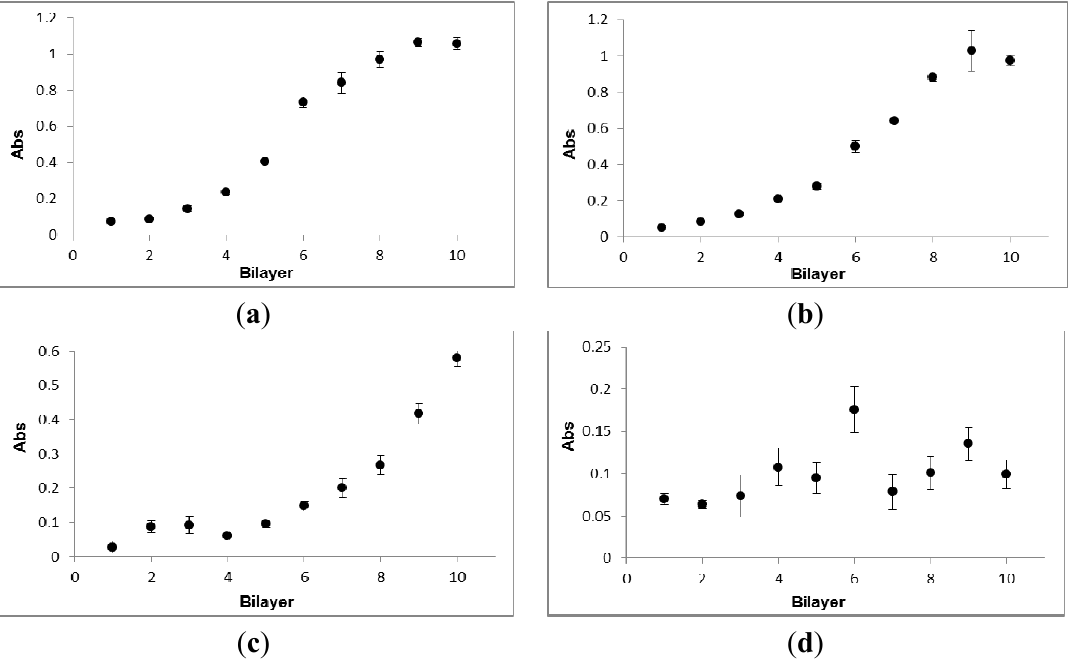
Figure 4. Plot of the average absorbance between 190–220 nm monitoring the growth of chitosan (CHI)/hyaluronan (HA) bilayers deposited by adaptations of the original protocol. Three trials were done for each bilayer to account for minor compositional variances. Water rinse was for 1 min. Error bars represent standard deviation. The following variations of the original protocol were performed: ( a ) Increased rinse times, volume, and frequency of solution changes (modified protocol); ( b ) Modified protocol where rinses were changed with every use (FS protocol); ( c ) Modified protocol with increased rinse volumes (Mulligan protocol); and ( d ) Modified protocol with increased rinse volume, time, and number of rinses (Richert